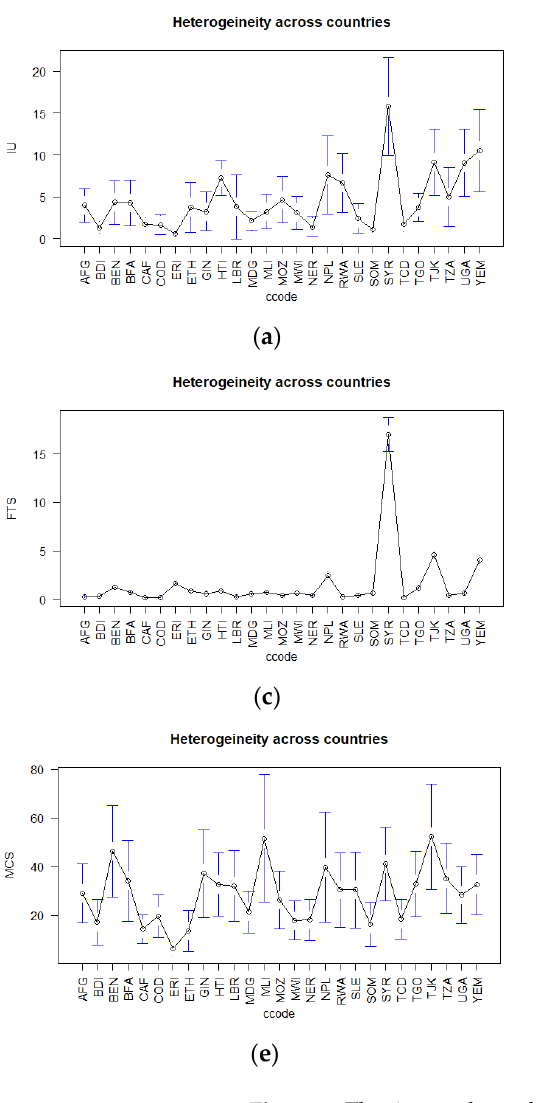
Table 1. Descriptive statistics.